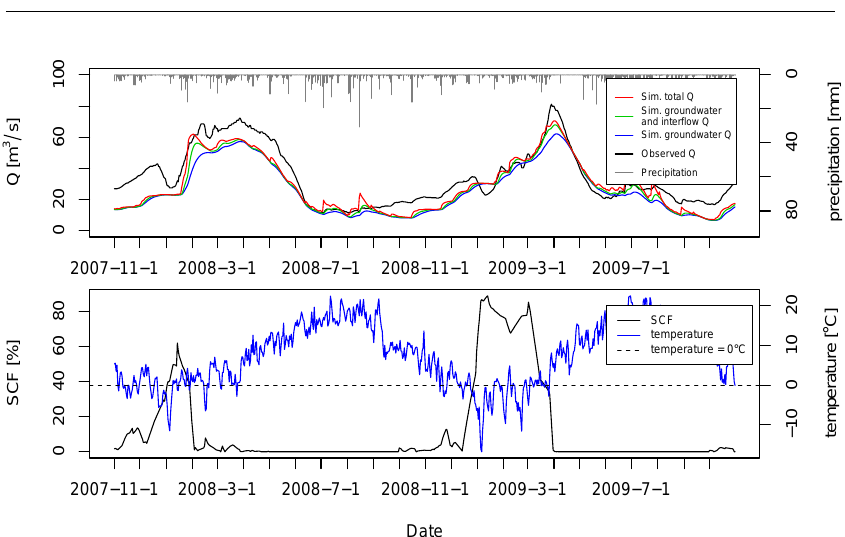
Figure 7. Observed and simulated daily discharge from the calibrated WetSpa for the period in which the sensitivity analysis was conducted (upper panel). Also presented is WetSpa simulated groundwater and interflow discharge as well as only groundwater discharge. Catchment average daily temperature and SCF in the same period is presented in the lower panel. The ticks on the time axis indicate the 1st day of a